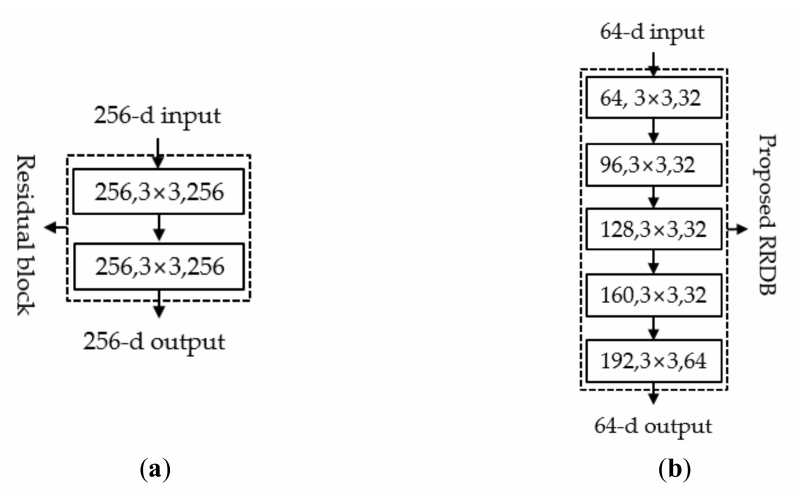
Figure 4. Equivalent building blocks, ( a ) EDSR residual block, ( b ) proposed model residual block (R RDB